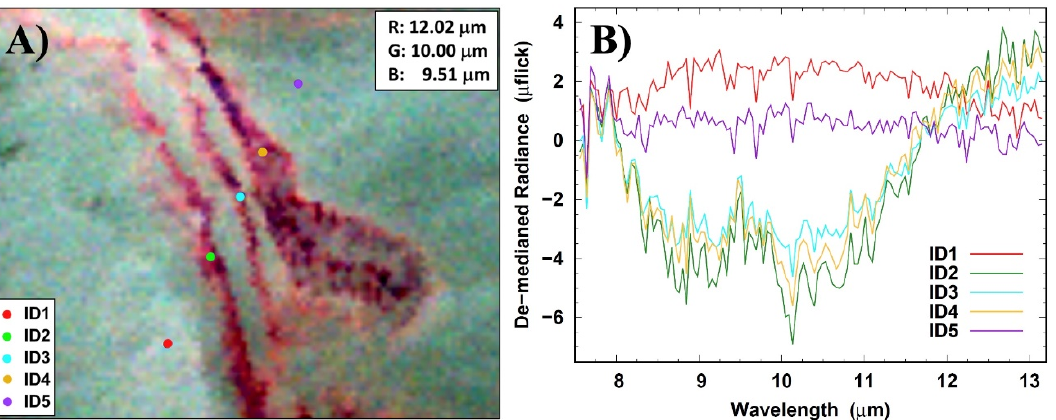
Figure 3. Spectral behavior of COP oil slick. ( A ) RGB coded radiance image with five spectral sampling locations shown. ( B ) De-medianed spectra extracted from sampling locations in panel ( A ).